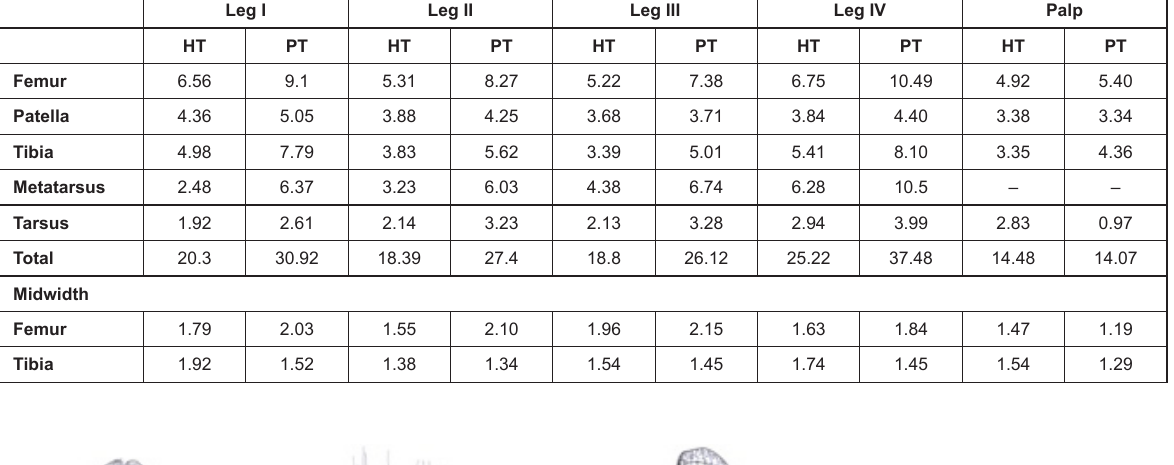
Table 3. Neoheterophrictus sahyadri sp. nov., measurements of legs and palp of holotype (WILD–10–ARA–1008), paratype (WILD–10–ARA–579)